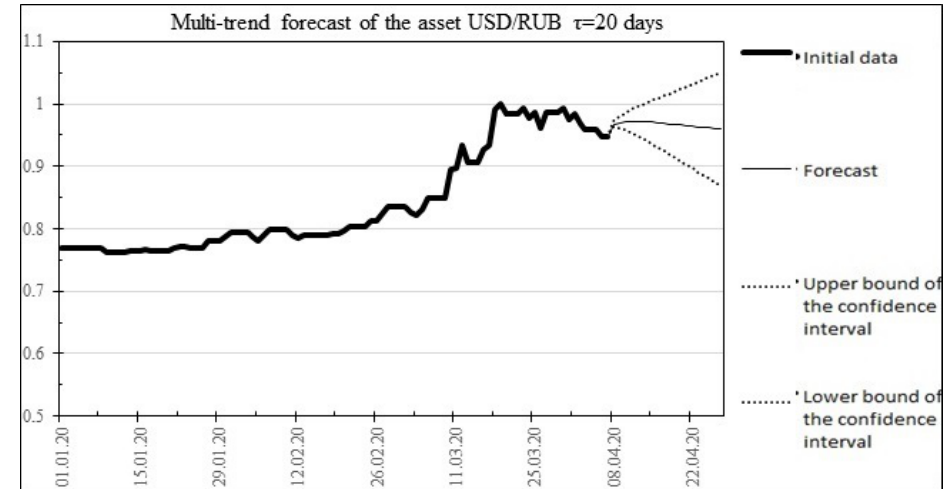
Figure 4. The result of the multitrend forecast for 20 days ahead for the USD/RUB